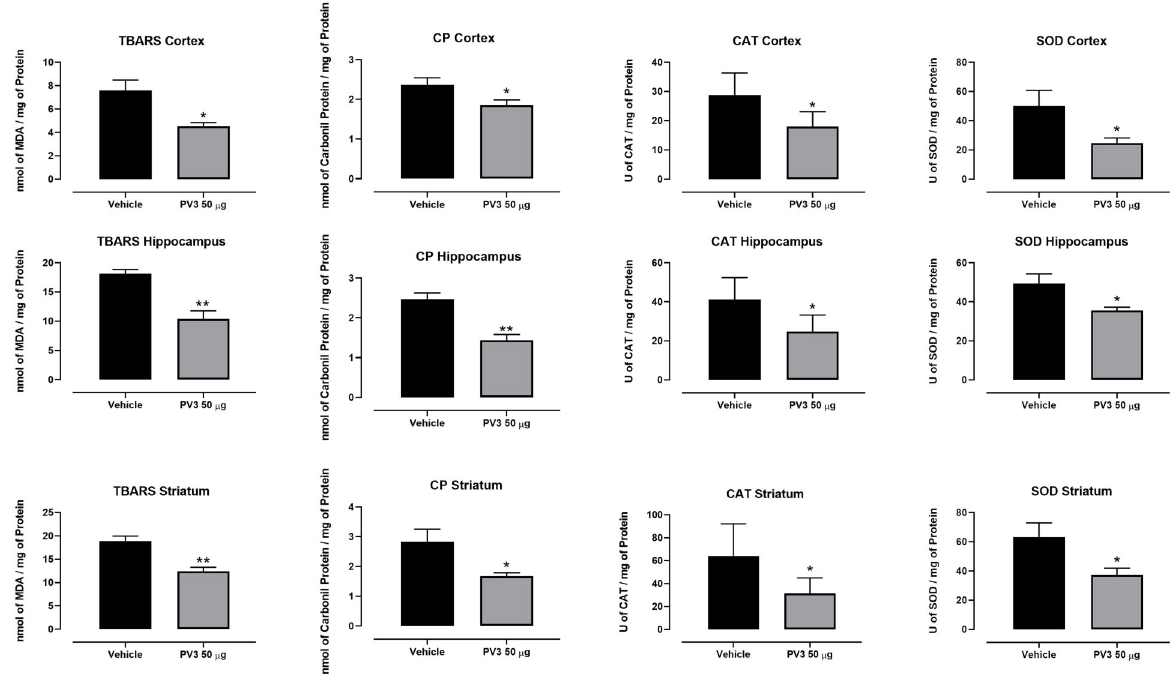
Figure 4. Evaluation of lipid peroxidation (TBARS), carbonylated proteins (CP), catalase (CAT), and superoxide dismutase (SOD) in the encephalic samples taken from rats acutely injected with Phaseolus vulgaris peptide (PV3) 50 m g/kg. Data are reported as means ± SE. *P o 0.05, **P o 0.01 ( t